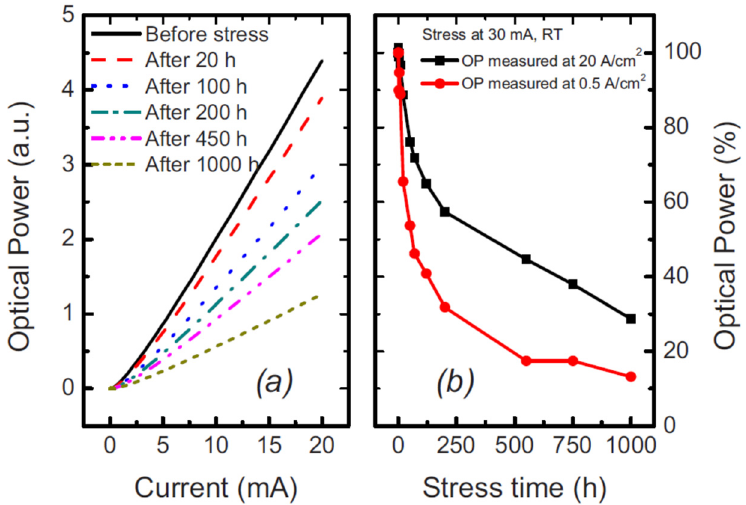
Figure 13. ( a ) L-I characteristics, ( b ) OP degradation. Reproduced with permission. [62] Copyright 2010, AIP.